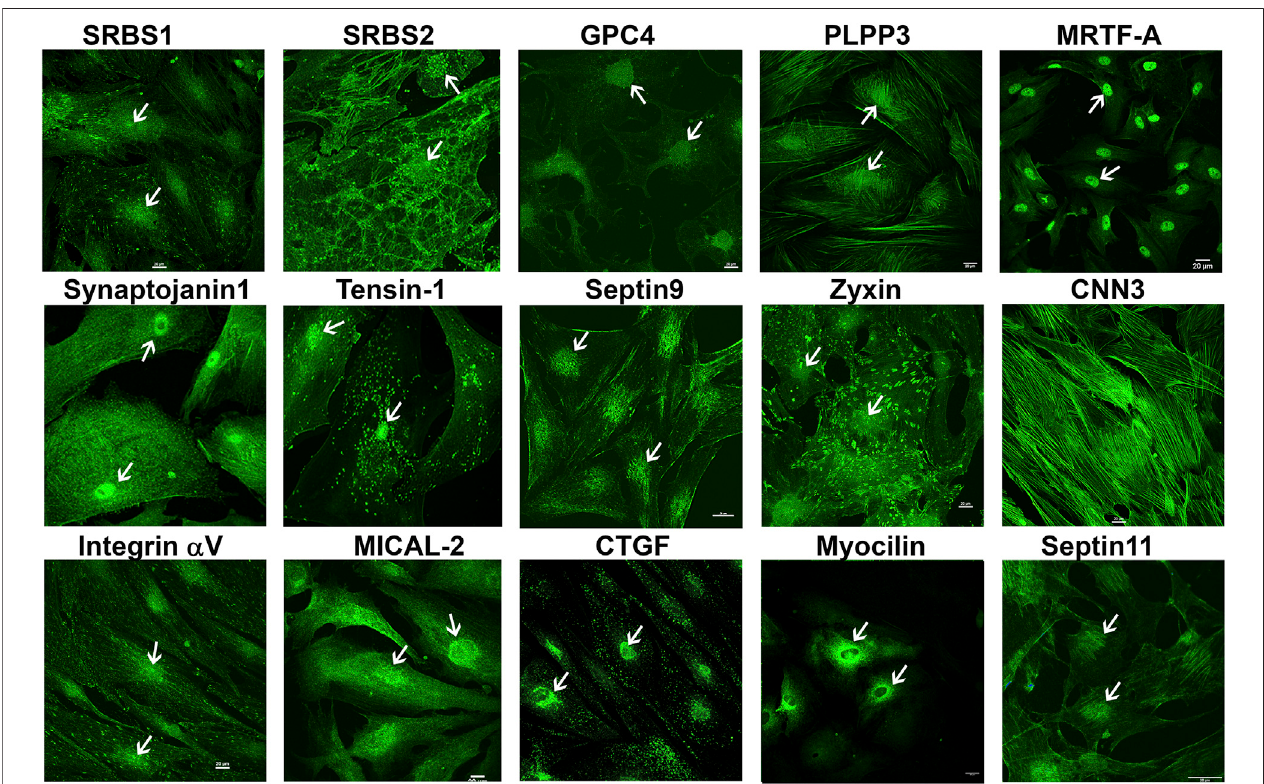
FIGURE 4 | Immuno fl uorescence based distribution pattern of proteins whose levels were increased in the nuclear protein fraction of human TM cells treated with Dex.SeveraloftheindicatedproteinsweredetectedinboththecytosolandnucleusofhumanTMcellsunderuntreatedcondition.Arrowsindicatethecellnucleus.Scale bars indicate magni fi